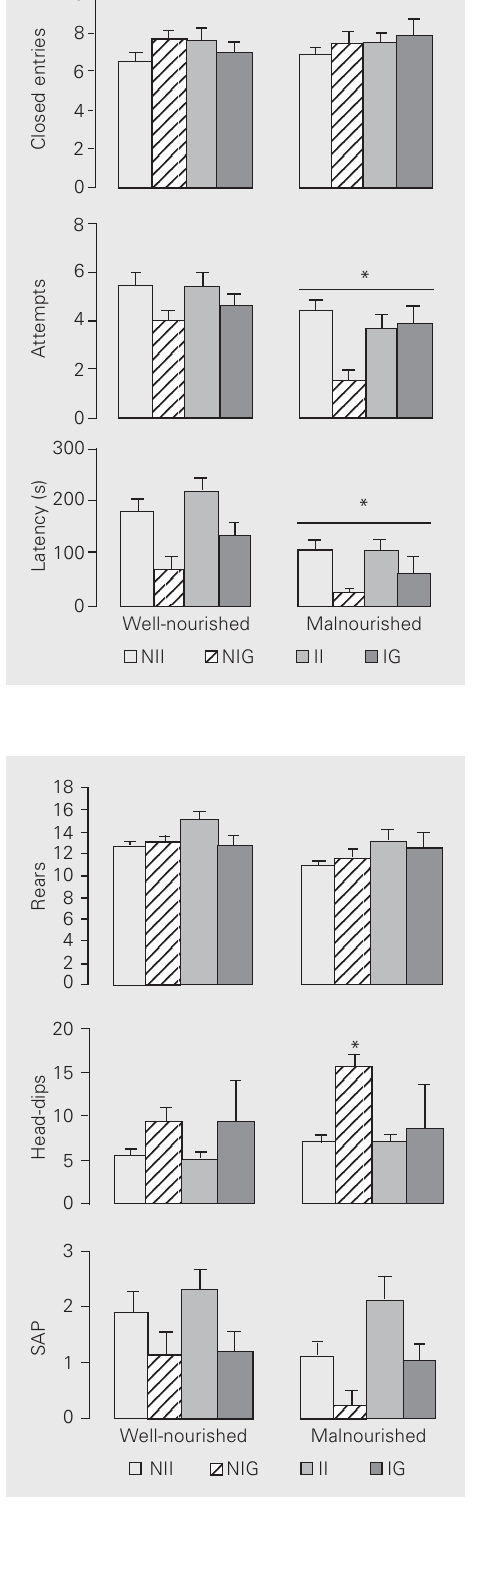
Figure 2. Number of closed-arm entries (top), attempts to enter into open arms (middle) and la- tencies for the first open-arm entry (bottom) by non-immobi- lized animals reared individually (NII) or in groups (NIG) and im- mobilized animals reared indi- vidually (II) or in groups (IG). Data are reported as means ± SEM for 17-57 rats in each group. *P < 0.05 compared to well-nourished animals (New- man-Keuls test).